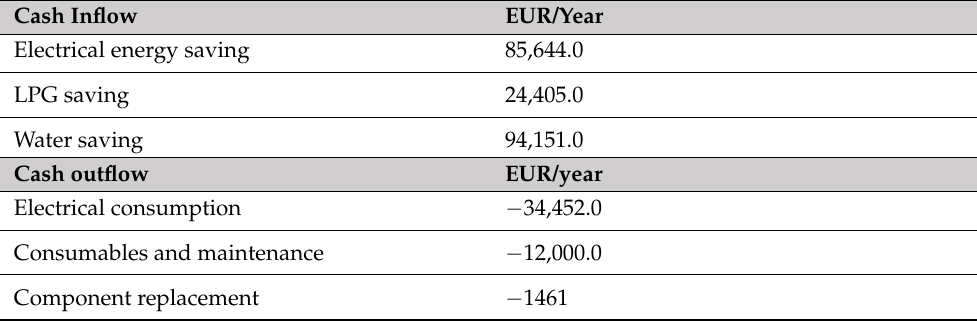
Table 5. Yearly cash